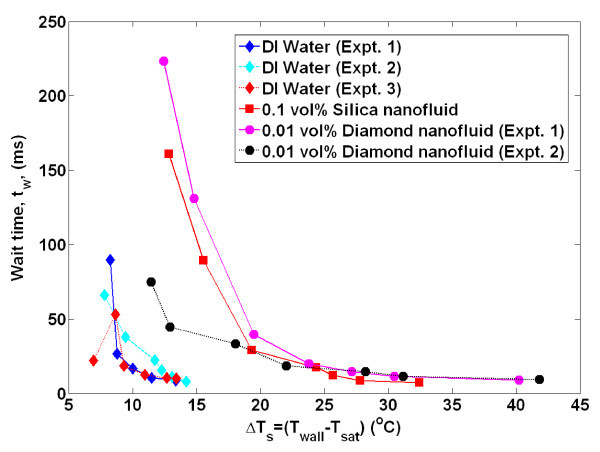
Average wait time as measured by infrared thermometry. Uncertainty in wait time is ± 20%.